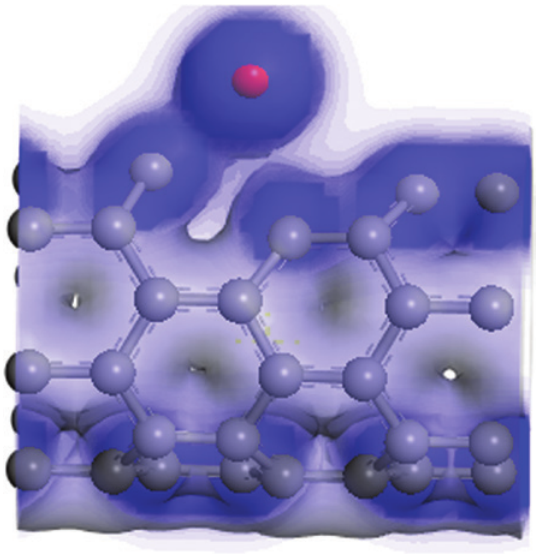
Figure 4: The total electron density of Pb 2 + -SV-(6, 0)